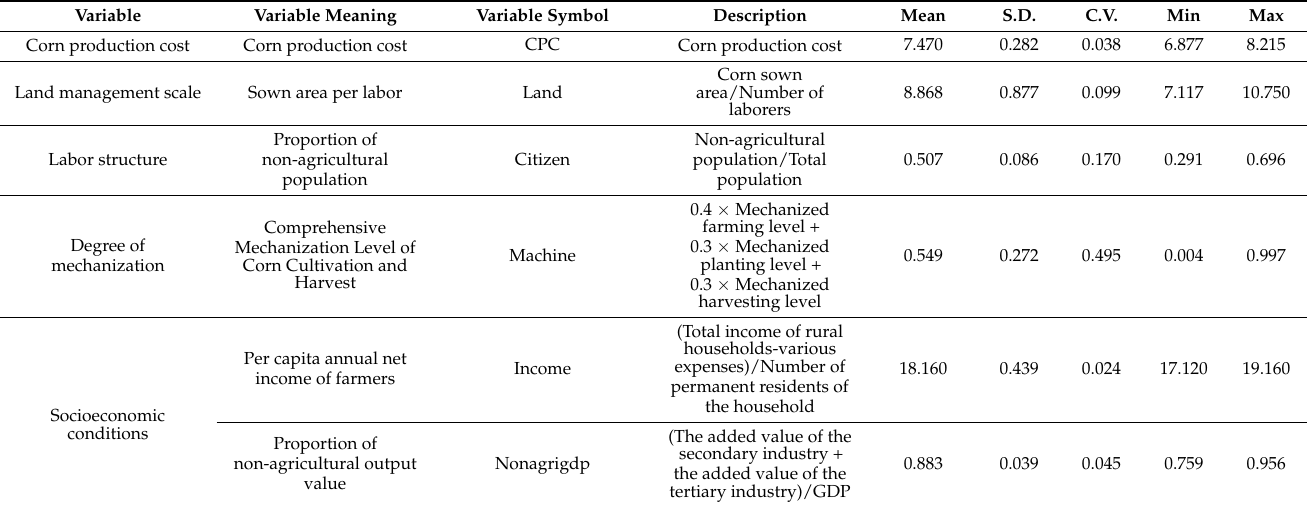
Table 1. Variable meaning and descriptive statistical